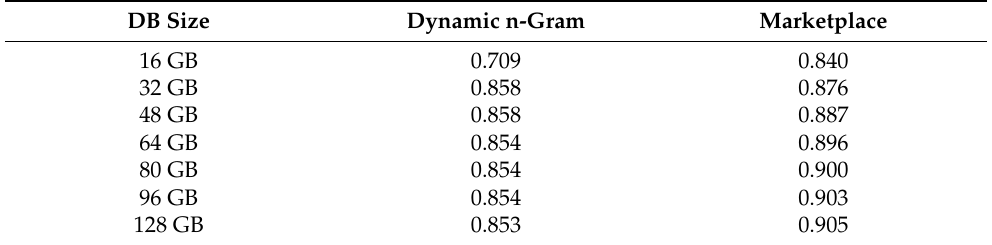
Table 3. The effect of database size on retrieval accuracy (MRR) for the dynamic n-gram and marketplace